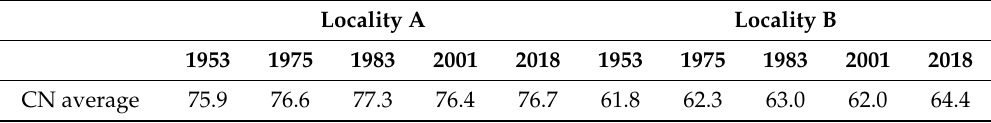
Table 6. Long-term development of average CN value for the individual sites